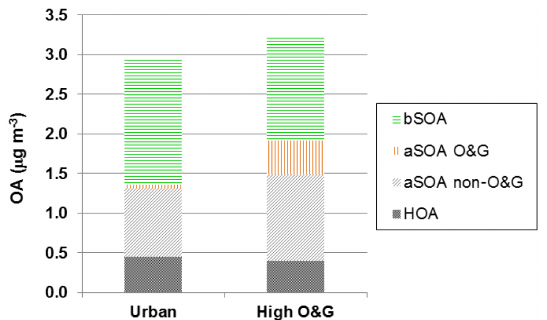
Figure 11. Contributions from HOA, aSOA (non-O&G and O&G sources), and bSOA to total OA as predicted by WRF-Chem in the case with non-volatile POA and limited bSOA formation assump-